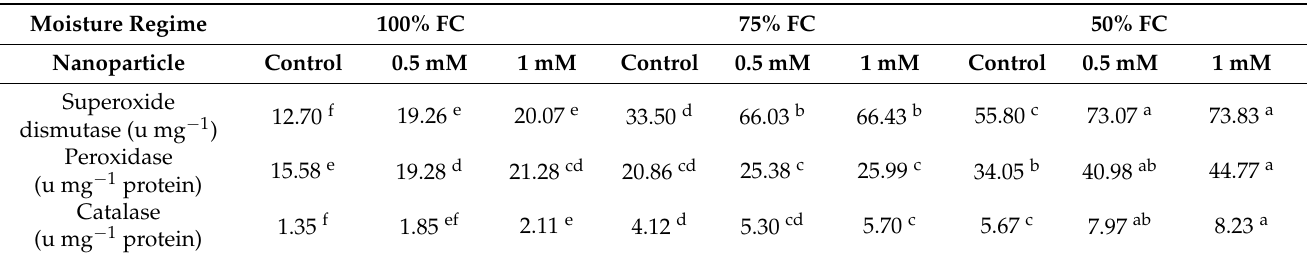
Table 11. Effect of moisture regime and nanoparticle on superoxide dismutase, peroxidase, and